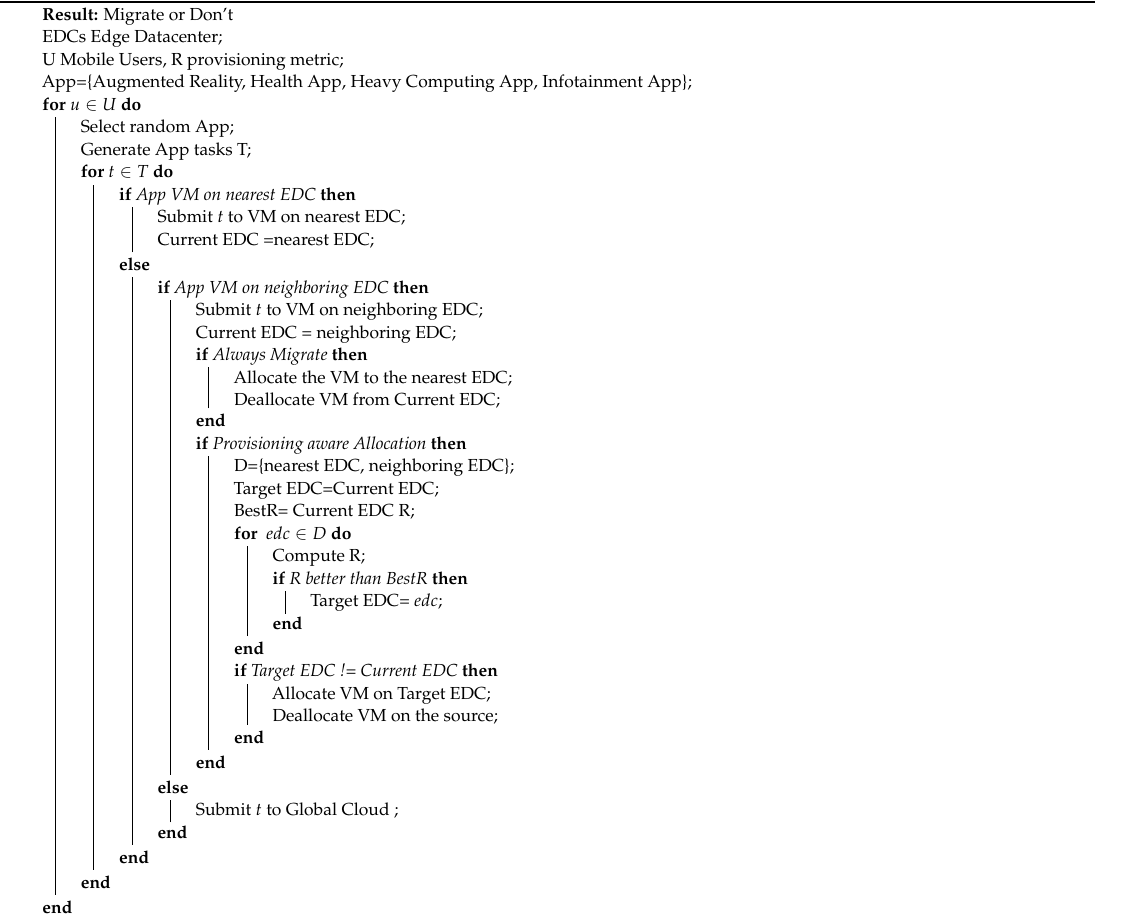
Algorithm 1: Migration Strategies